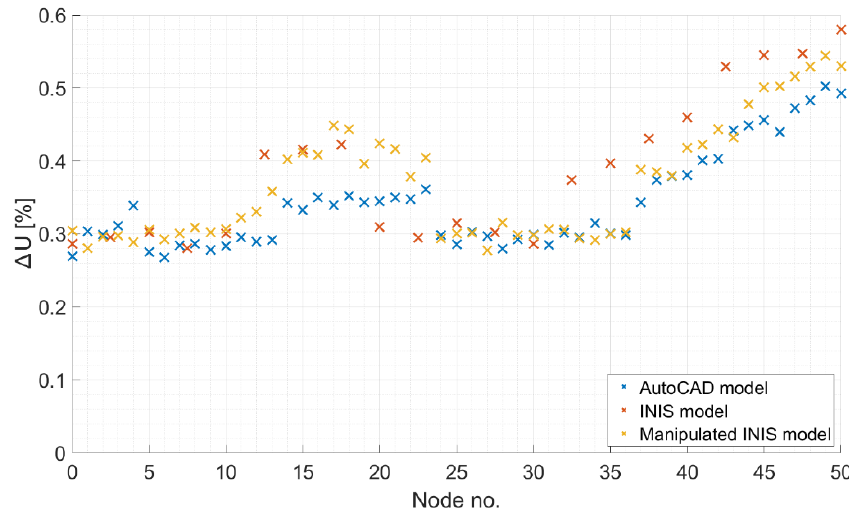
Figure 6. Average relative error of voltages for Area 18,680 with Method 2m.